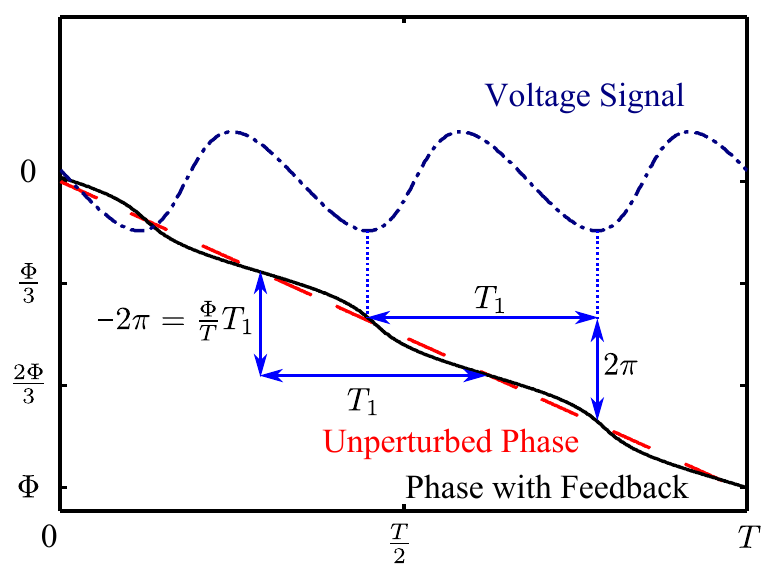
Figure 2. The blue chain line is the waveform of the self-mixing voltage signal, the black solid line is the phase of the laser with feedback, the red broken line is the the round trip phase delay in the external